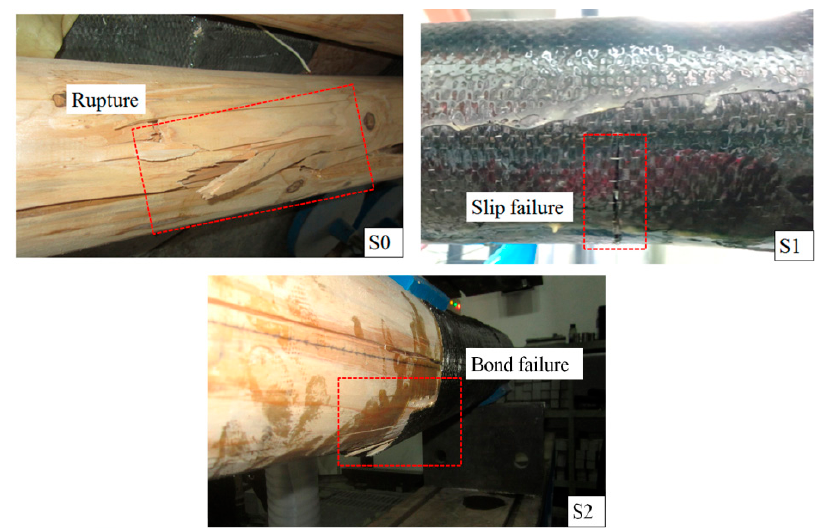
Figure 11. Failure modes of shearing beams.